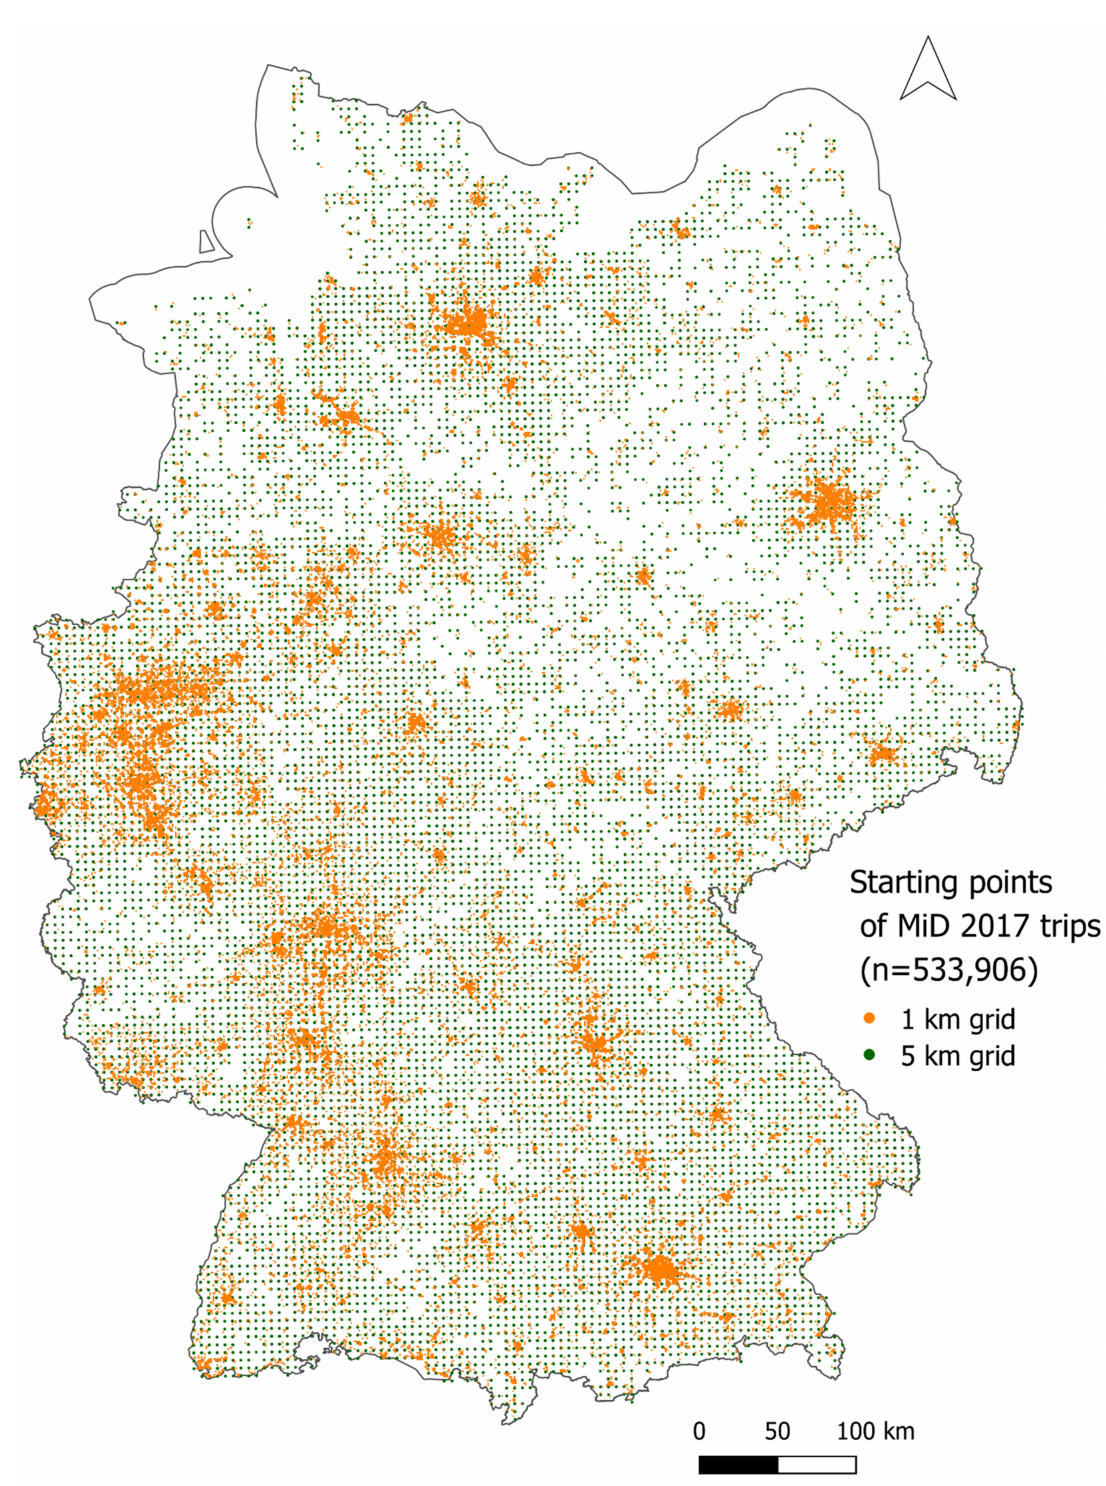
Figure 1. The distribution of the points of the trip departures in Germany is shown. The green dots indicate the centroid of the trip departures, which were available in a 5 km grid cell, while the orange dots denote the centroid of the trip departures, which were available in 1 km grid cells. The size of the grid cells was determined by privacy protection regulations, i.e., if only few people lived in a 1 km grid cell containing the point of departure of a certain trip, then for that trip the respective 5 km grid cell of the inspire grid system was chosen in order to have more residents within the grid cell and to make the identification of the actual person that conducted the trip in question more